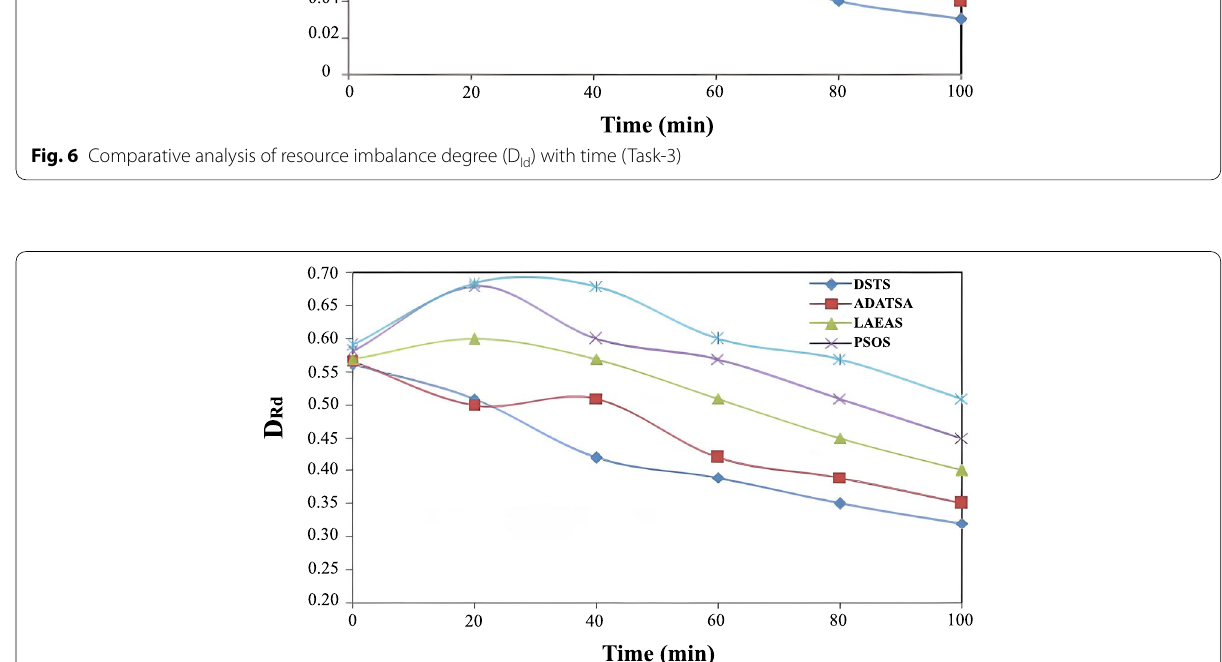
Fig. 7 Comparative analysis of resource residual degree (D Rd ) with time